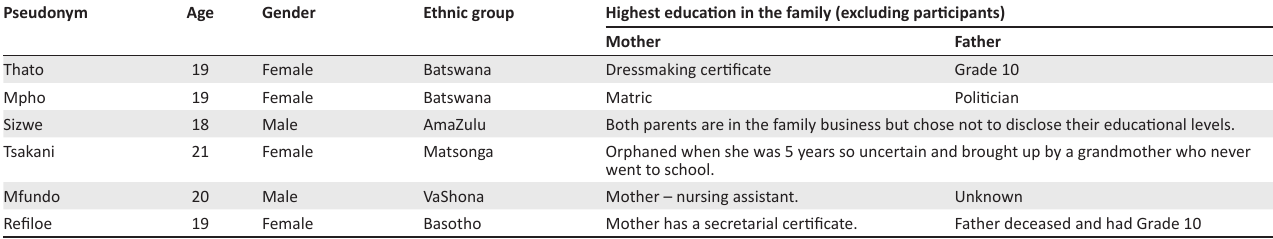
TABLE 1: Biographical information of participants.